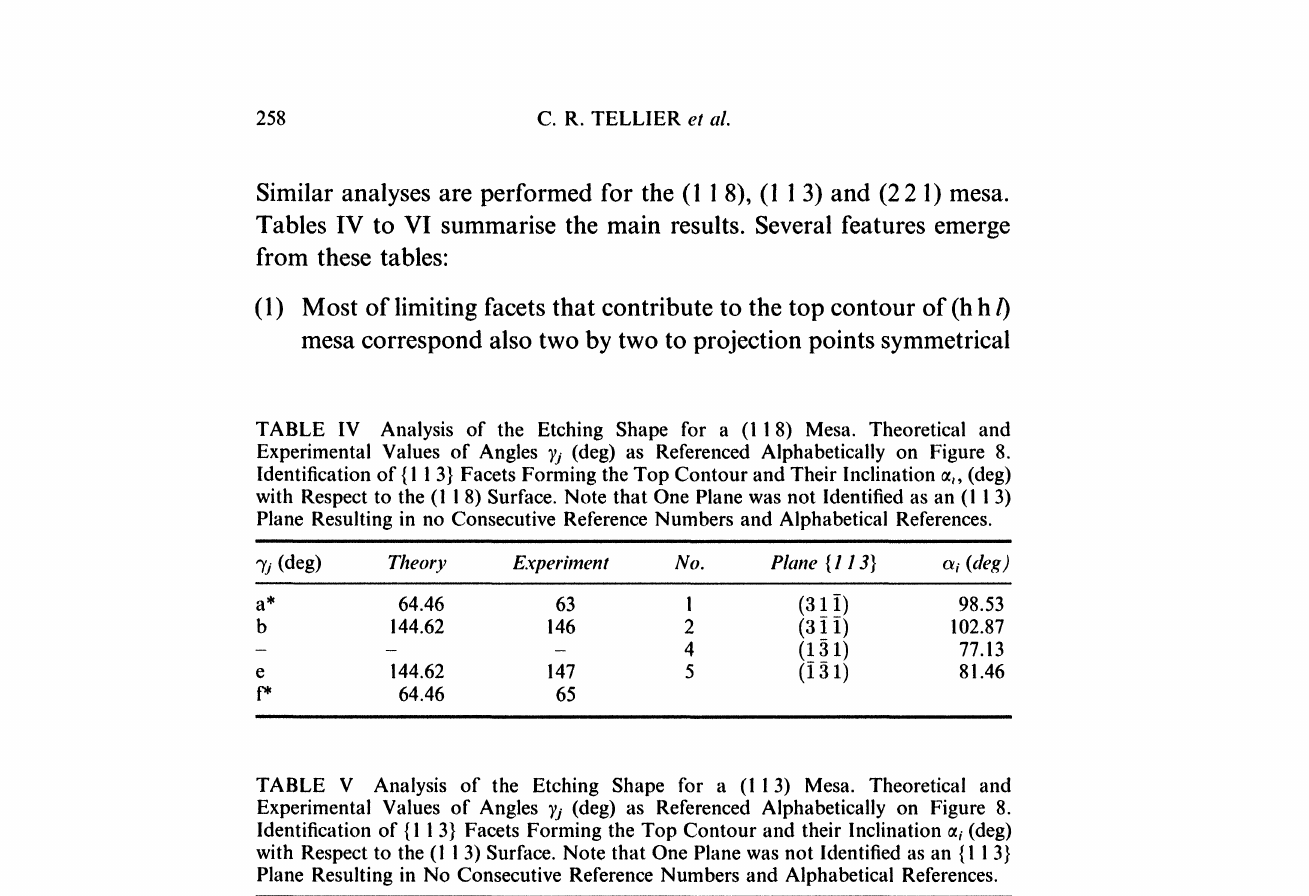
TABLE V Analysis of the Etching Shape for a (l 13) Mesa. Theoretical and Experimental Values of Angles ),j (deg) as Referenced Alphabetically on Figure 8. Identification of 3} Facets Forming the Top Contour and their Inclination ; (deg) with Respect to the (1 3) Surface. Note that One Plane was not Identified as an 3} Plane Resulting in No Consecutive Reference Numbers and Alphabetical References.